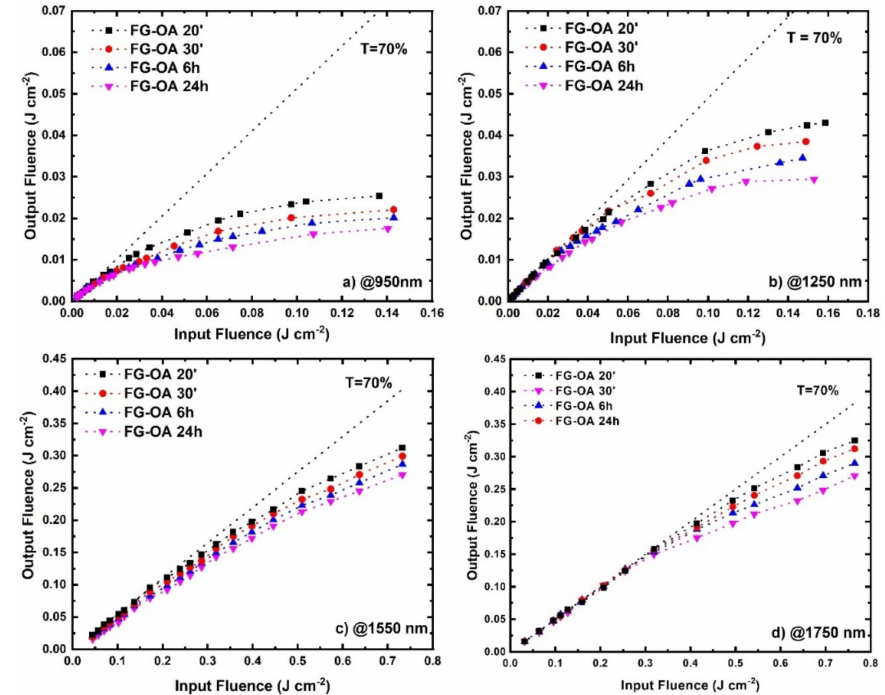
Figure 6. Optical limiting action of FG-OAxs under ( a ) 950, ( b ) 1250, ( c ) 1550 and ( d ) 1750 nm laser